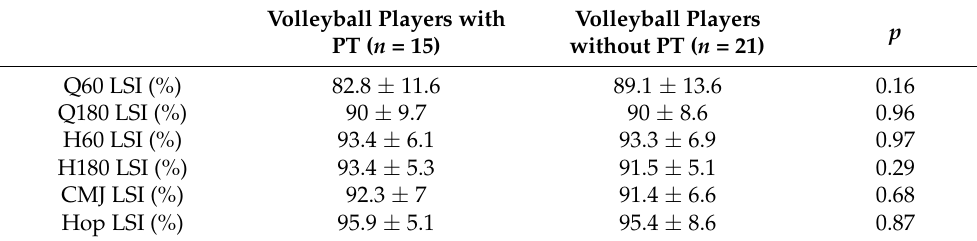
Table 2. LSI Comparison between volleyball players with and without patellar tendinopathy.